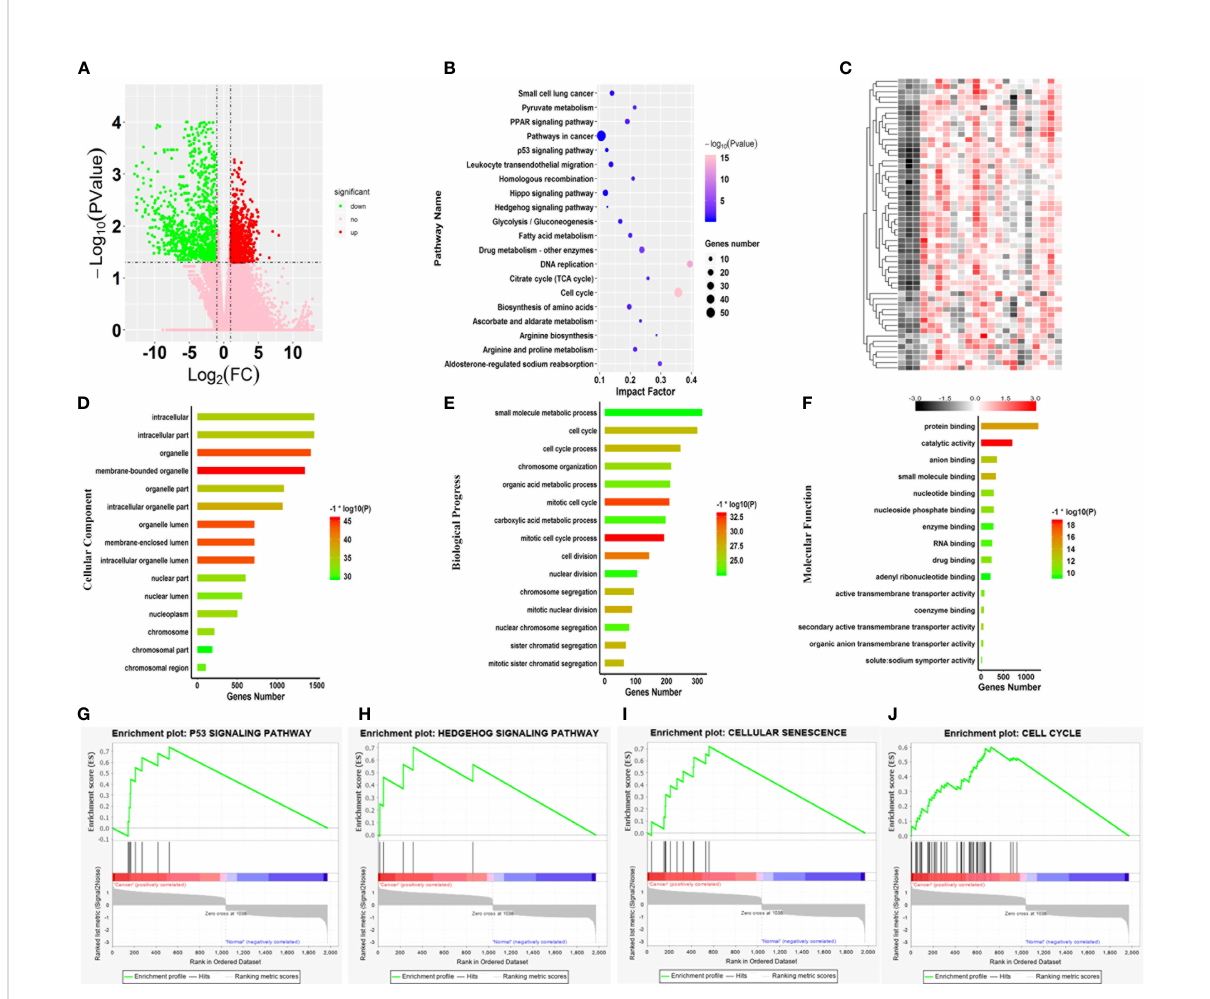
FIGURE 3 Core variations between SARC and normal tissue. (A) Volcano plot of the aberrant genes of SARC and noncancer samples from TCGA. (B) Kyoto Encyclopedia of Genes and Genomes pathway analysis of the differentially expressed genes. (C) Heatmap of genes differentially expressed genes involved in key pathways in the SARC dataset. Gene ontology enrichment analysis of the differentially expressed genes; (D) Cellular component; (E) Biological process; and (F) Molecular function. (G – J) Enrichment plots from gene set enrichment analysis (GSEA); (G) P53 signaling pathway, (H) Hedgehog signaling pathway, (I) cellular senescence, (J) cell